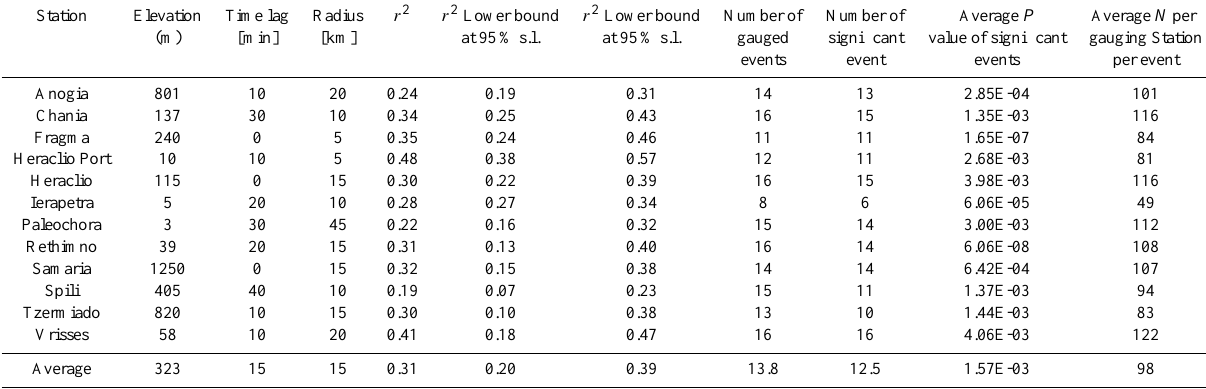
Table 2. Average coefficient of determination for the optimum combination of time lag and radius, average upper and lower bounds of coefficients of determination attained at 95% significance level (s.l.), number of gauged and number of the statistically significant events among the 16 analysed events, the average P -value of statistically significant events, and average number of samples ( N ) used to derive correlations per gauging station per event. The location of the stations is presented in Fig. 1a., the optimum radius in Fig. 1b., the optimum time-lag in Fig. 1c. and the attained r 2 in Fig. 1d.